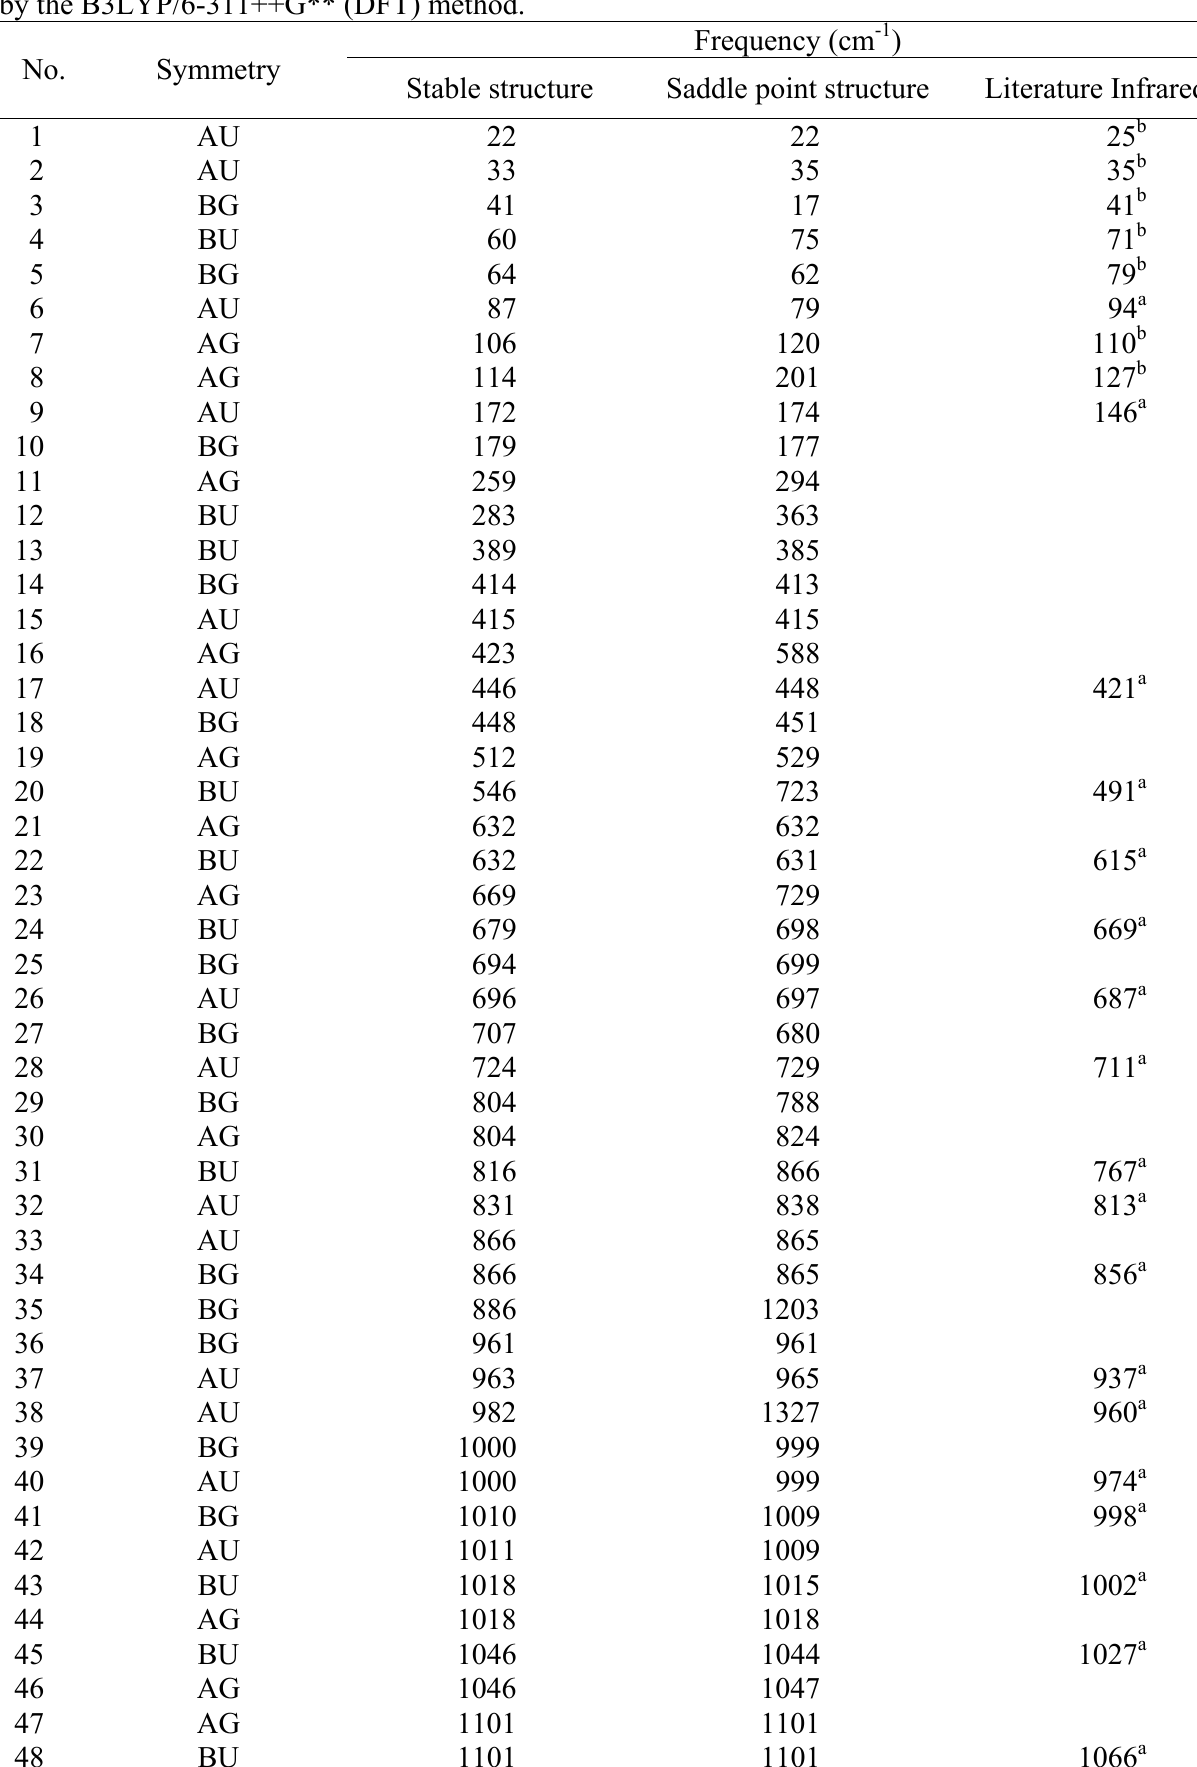
Table 2. Calculated normal mode frequencies for the stable and saddle point structures of benzoic acid by the B3LYP/6-311++G** (DFT)